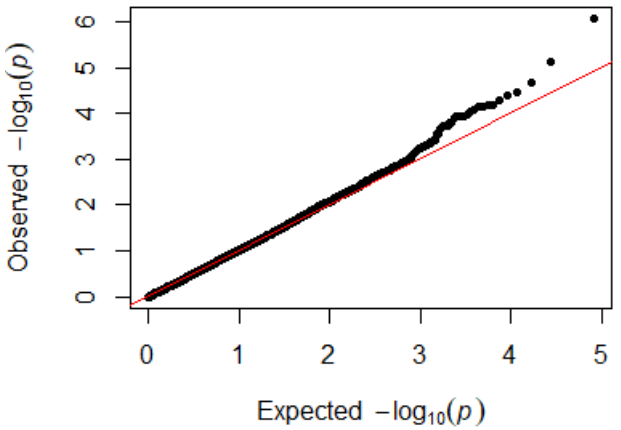
Figure 3. Quantile – quantile plots of p -values for lymphocytes. The x-axis is the expected − log10 p - value and the y-axis is the observed − log10 p -value.